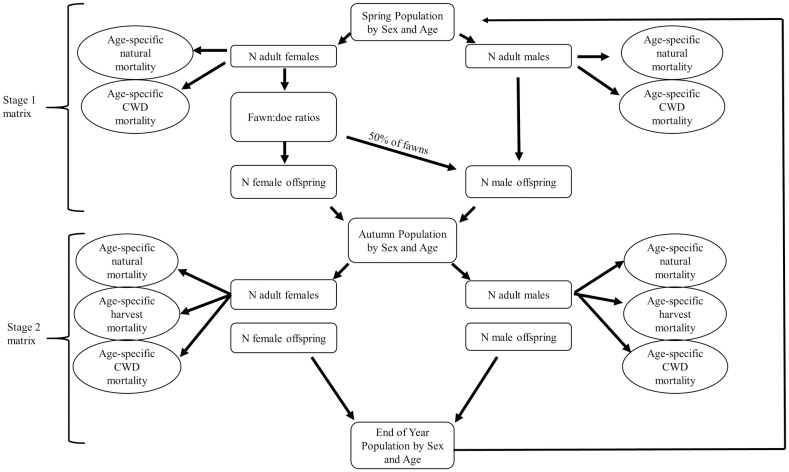
Schematic representing the white-tailed deer life cycle used in CWD simulations.